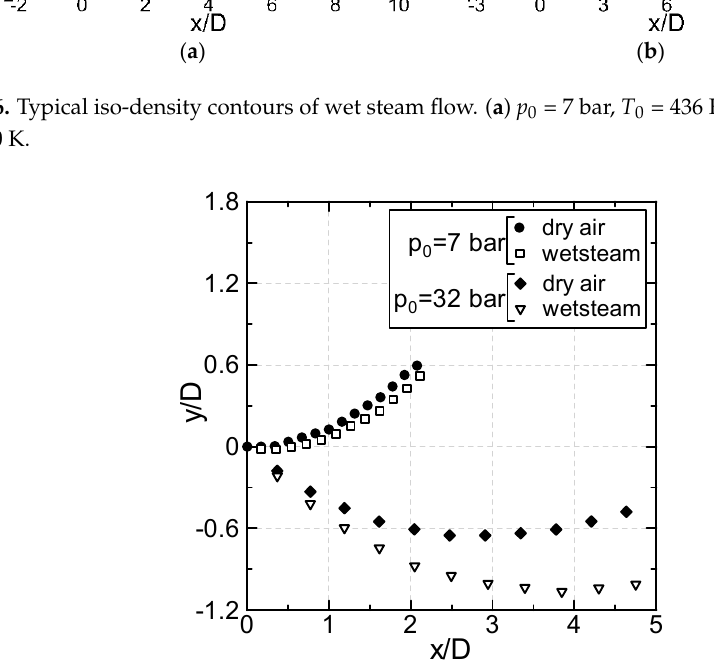
Figure 7. Configurations of the lower shock cell boundary.